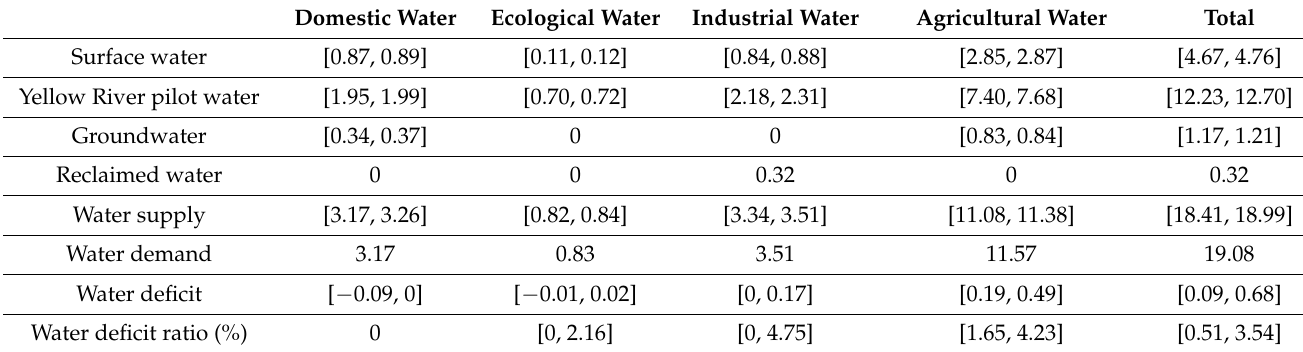
Table 5. Harmonious water resource allocation result for 2025 ( × 10 8 m 3 ).